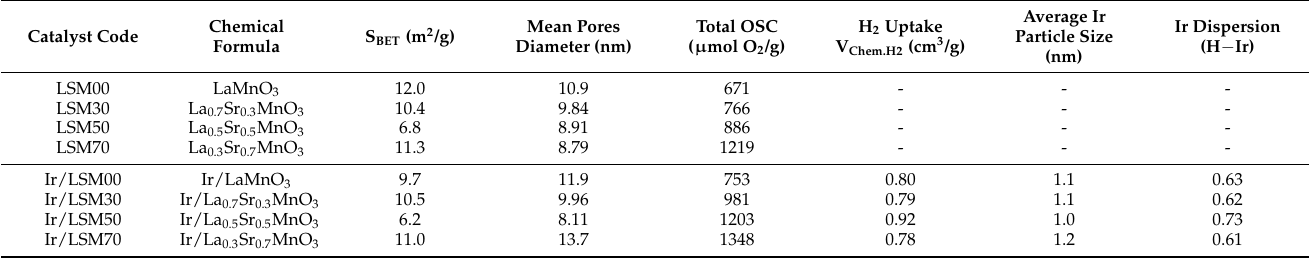
Table 1. Textural and morphological characteristics and physicochemical properties of LSMx and 2 wt% Ir/LSMx